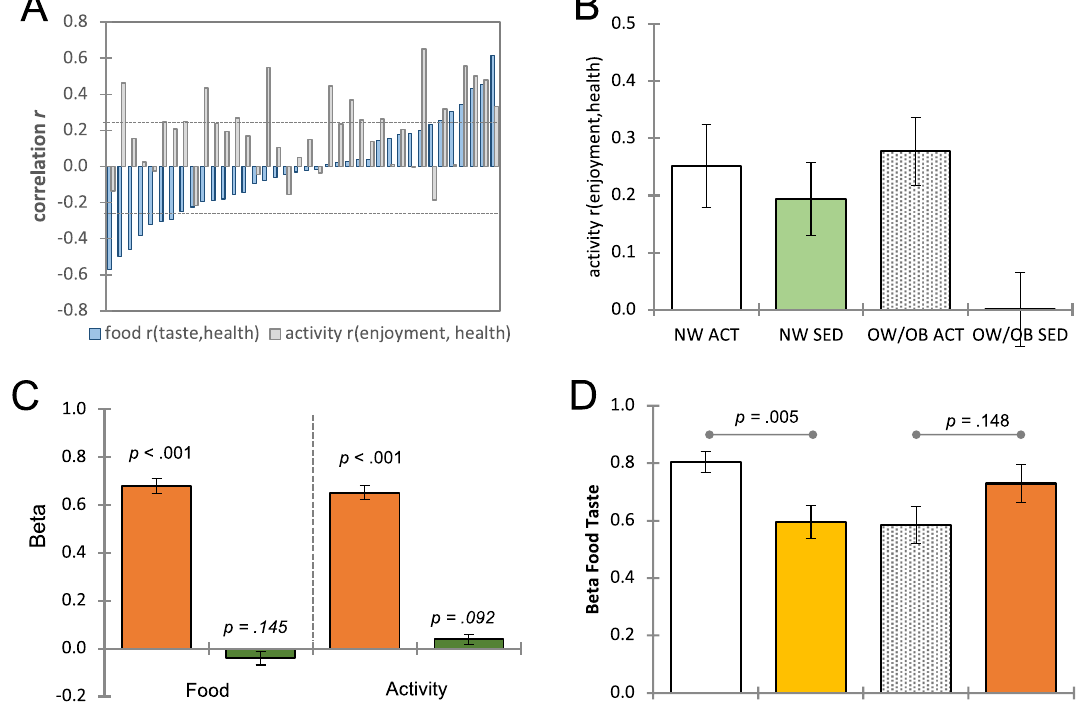
Figure 2. ( A ) Participants’ correlation coefficients of food taste and health ratings and activity enjoyment and health ratings are shown in ascending order of food correlation coefficients. The dotted lines indicate the critical r values at the individual level (± 0.254 at p < 0.05). ( B ) The correlations between activity enjoyment and health ratings were significantly different between active (ACT) and sedentary (SED) groups. ( C ) Adolescents’ food decisions were solely predicted by taste ratings, and activity decisions were solely predicted by enjoyment ratings. ( D ) The food taste beta weights were significantly different between normal weight active (NW ACT) and normal weight sedentary (NW SED) groups, while they were not different between overweight/obese active (OW/OB ACT) and overweight/obese sedentary (OW/OB SED) groups. All error bars denote standard errors. n =